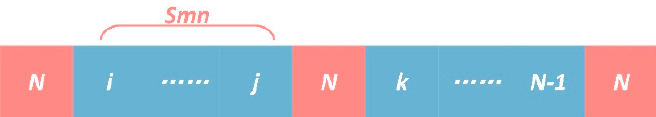
Figure 5. The chromosome code of the random individual in the population.